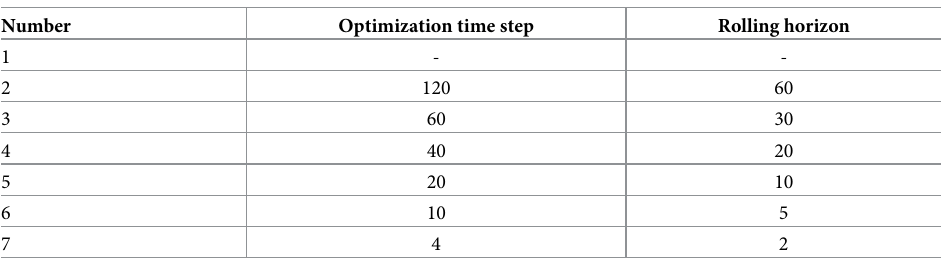
Table 3. Optimization time steps and rolling horizon